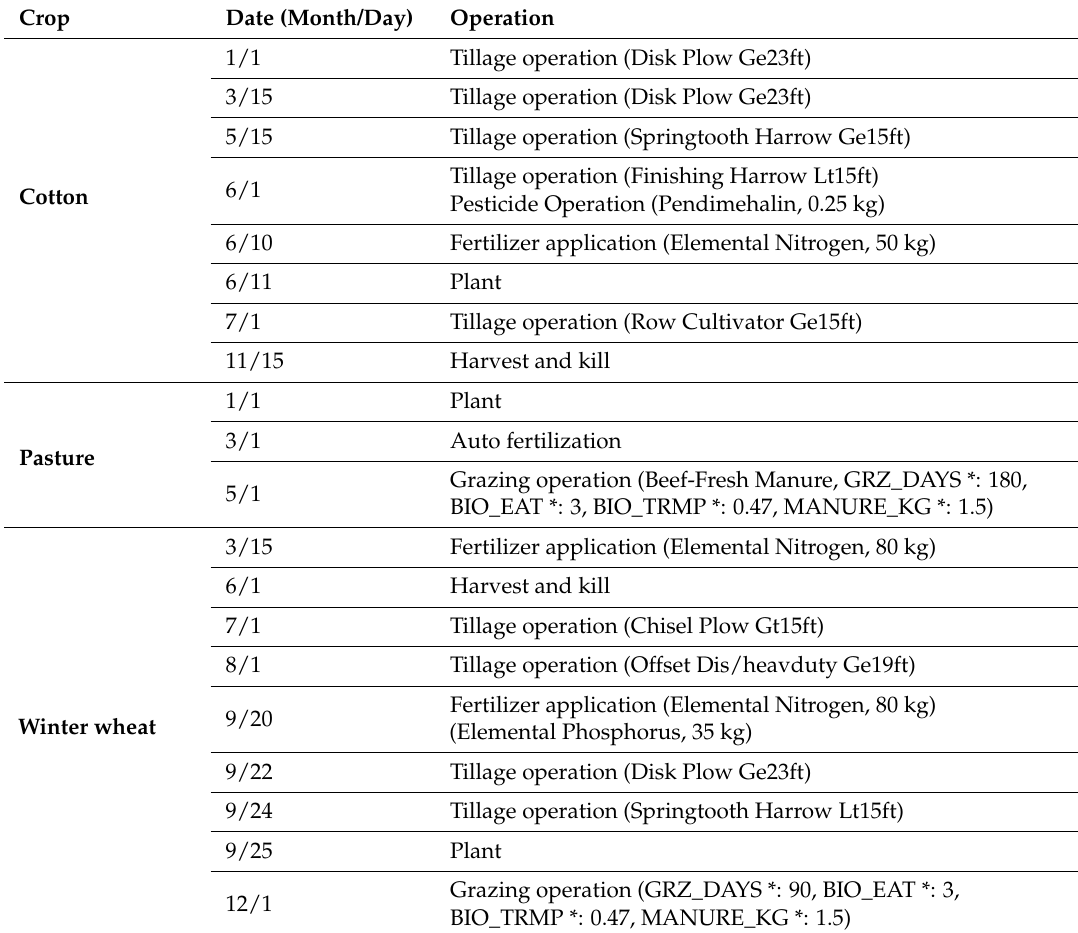
Table A1. Conventional or reduced tillage for dryland crops and pasture in the study